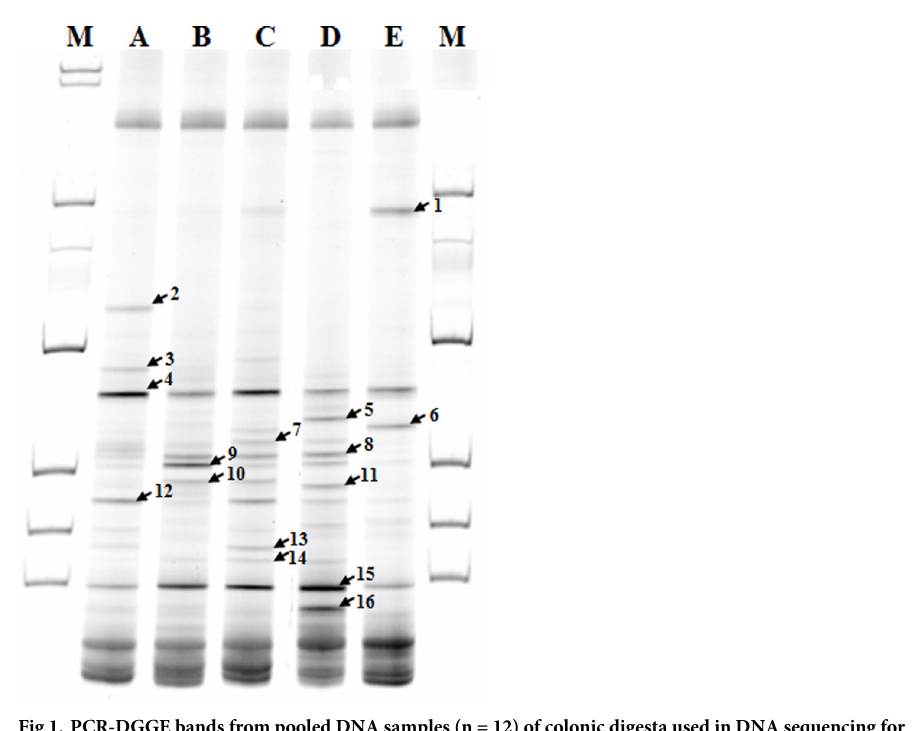
Fig 1. PCR-DGGE bands from pooled DNA samples (n = 12) of colonic digesta used in DNA sequencing for identification of bacteria. Arrows indicate the bands subject to DNA sequencing. M, marker; A, control; B, high fat; C, high sucrose; D, iron deficiency; E, processed meat.